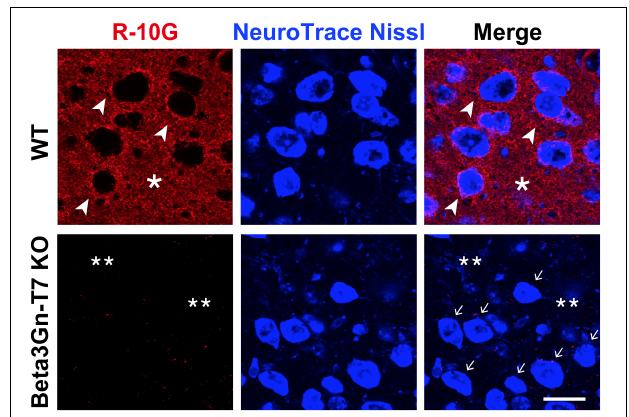
FIGURE 1 | R-10G anti-keratan sulfate-staining signals in the neuropils and pericellular regions are negligible in the adult brain of Beta3Gn-T7 KO mice. Brain sections from adult WT and Beta3Gn-T7 KO mice were immunostained with R-10G ( red ) followed by NeuroTrace Nissl staining ( blue ). Representative confocal microscope images in layer 2/3 of the visual cortex are shown ( n = 3 for WT and KO mice). Dense R-10G staining signals in the pericellular spaces ( arrowheads ) were deficient in Beta3Gn-T7 KO mice ( arrows ). Diffuse R-10G staining signals in intercellular spaces ( asterisks ) were deficient in Beta3Gn-T7 KO mice ( double asterisks ). Digital images were captured in the same settings for each staining. Scale bar: 10 µ